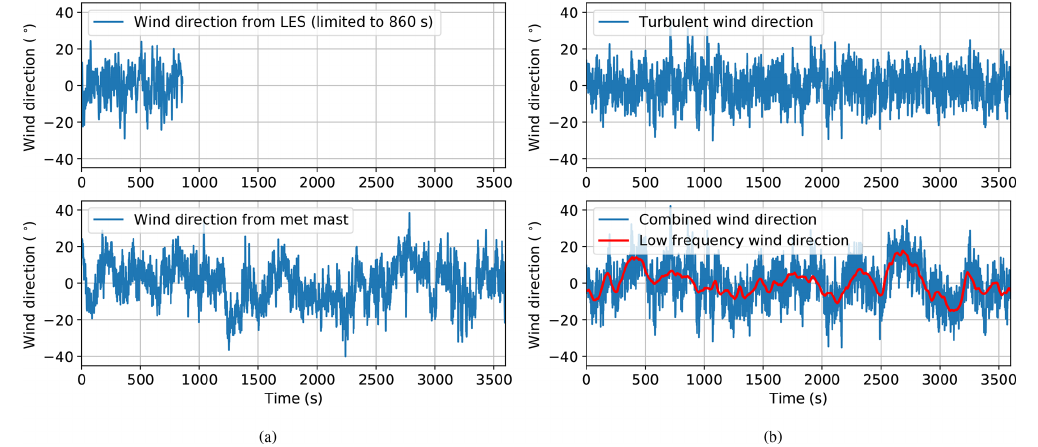
Figure 5. Example wind direction time series: (a) wind directions from LES and met mast wind vane measurements and (b) stochastic turbulent, low-frequency, and combined wind